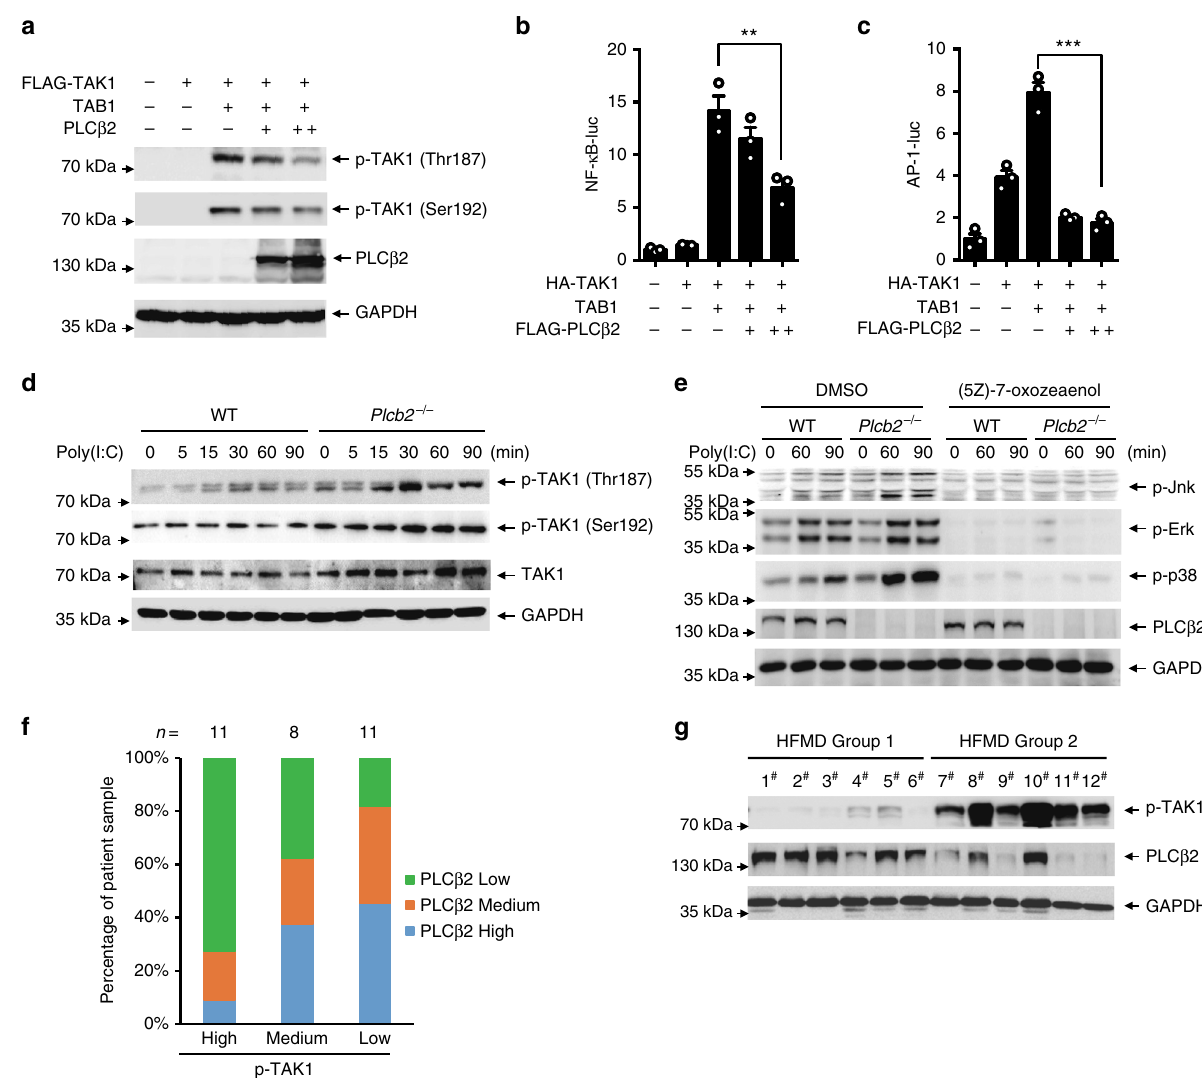
Fig. 4 PLC β 2 inhibits TAK1 activation. a IB of cell lysates from HEK293 cells expressing TAK1 and TAB1 in the presence or absence of PLC β 2. b , c Reporter assay of NF- κ B ( b ) and AP-1 ( c ) activation in HEK293T cells expressing TAK1 and TAB1 with increasing concentrations of PLC β 2. d Immunoblot analysis of lysates from wild-type or Plcb2 − / − macrophages treated with poly(I:C) for the indicated times using phospho-TAK1 antibody. e IB of lysates from wild-type or Plcb2 − / − macrophages pretreated with TAK1 inhibitor, (5Z)-7-oxozeaenol, for 1 h, then stimulated with poly(I:C) for the indicated times using anti- phospho-antibodies. f , g IB of PLC β 2 and p-TAK1 in PBMC from HFMD patients. Both PLC β 2 and p-TAK1 levels were classi fi ed as low, medium, or high based on the intensities of each band; the percentages of patients classi fi ed in each category are depicted the histogram in ( f ) and the representative IB is shown in ( g ). ** p < 0.01 and *** p < 0.001 by unpaired t -test ( b , c ). Data are representative of three experiments with at least three independent